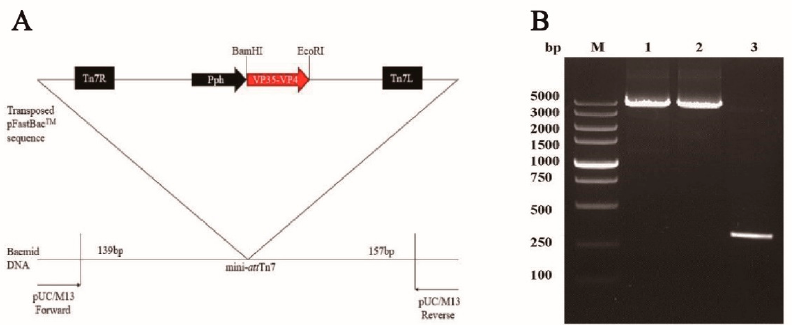
Figure 1. Construction and identification of the recombinant BmBacmid-VP35-VP4: ( A ) schematic construction of the recombinant baculovirus BmNPV-VP35-VP4; and ( B ) PCR amplification of VP35-VP4 from BmBacmid-VP35-VP4 (Lane M, DNA marker; Lanes 1–2, Bacmid-VP35-VP4; Lane 3, Bacmid alone).